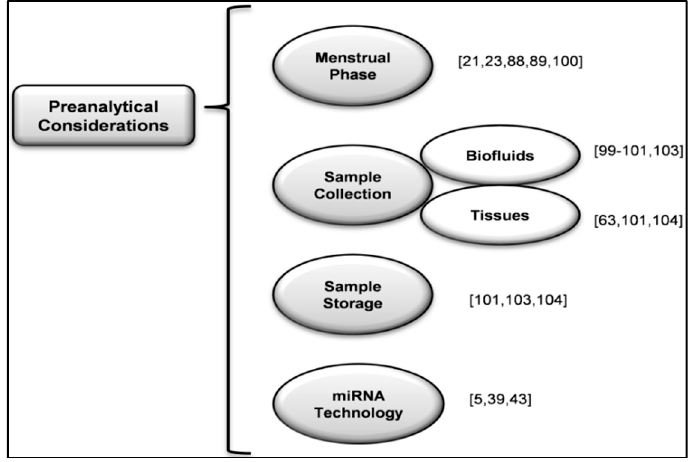
Figure 4. Preanalytical considerations for the miRNA study and relevant literature in square brackets in order to obtain robust conclusions in the standardization of new biomarkers in endometriosis.